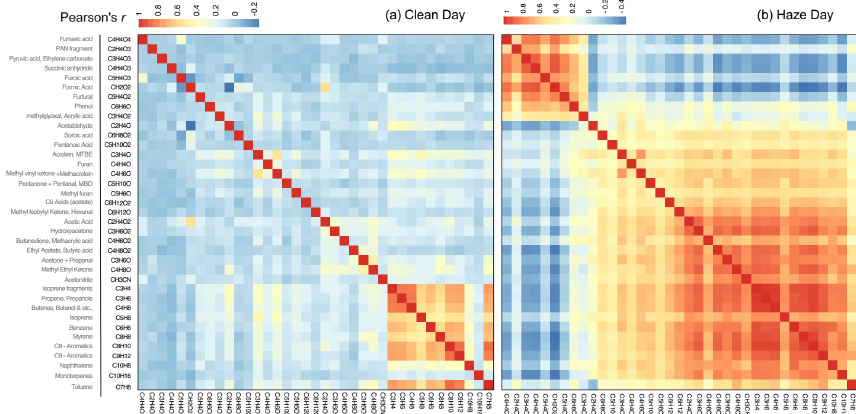
Figure 8. Correlation heat maps for the concentrations of the main VOCs and OVOCs measured during (a) the clean day on 18 Novem- ber 2018 and (b) the haze day on 14 November